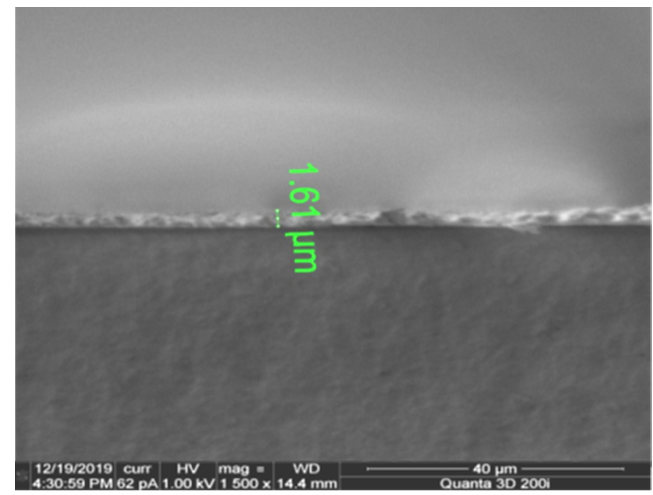
Figure 7. Thickness of 4-layer printed samples using SEM.